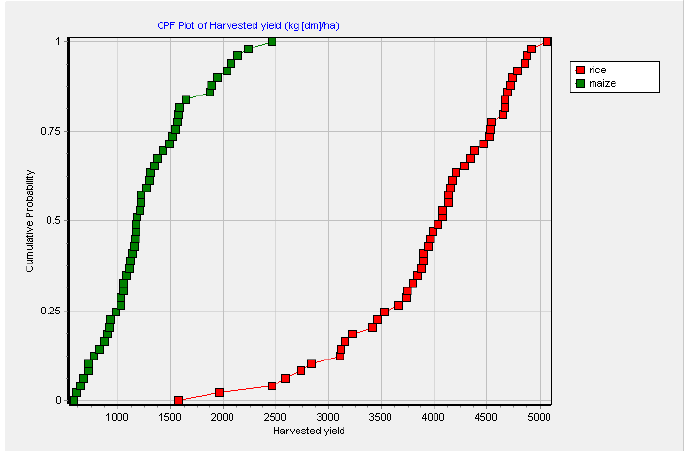
Figure 7. Cumulative probability distribution of rice and maize production in the future.